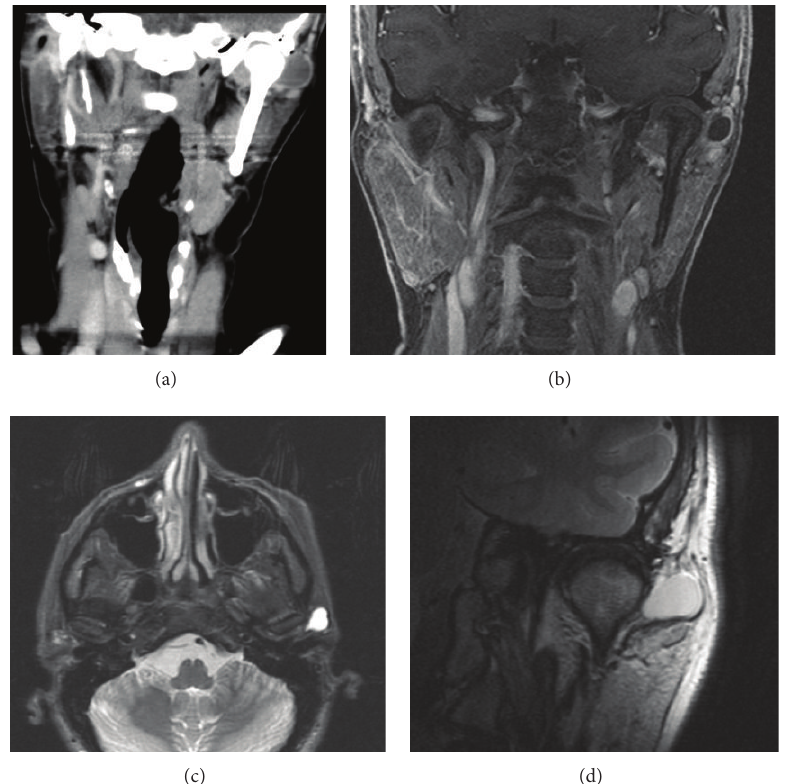
Figure 1: Imaging findings based on the coronal reconstruction of CT (a) and MRI sections (coronal with Gd-DTPA (b), axial STIR (c), and coronal FSE-T2 (d)) showing the features of a cystic lesion adjacent to the left